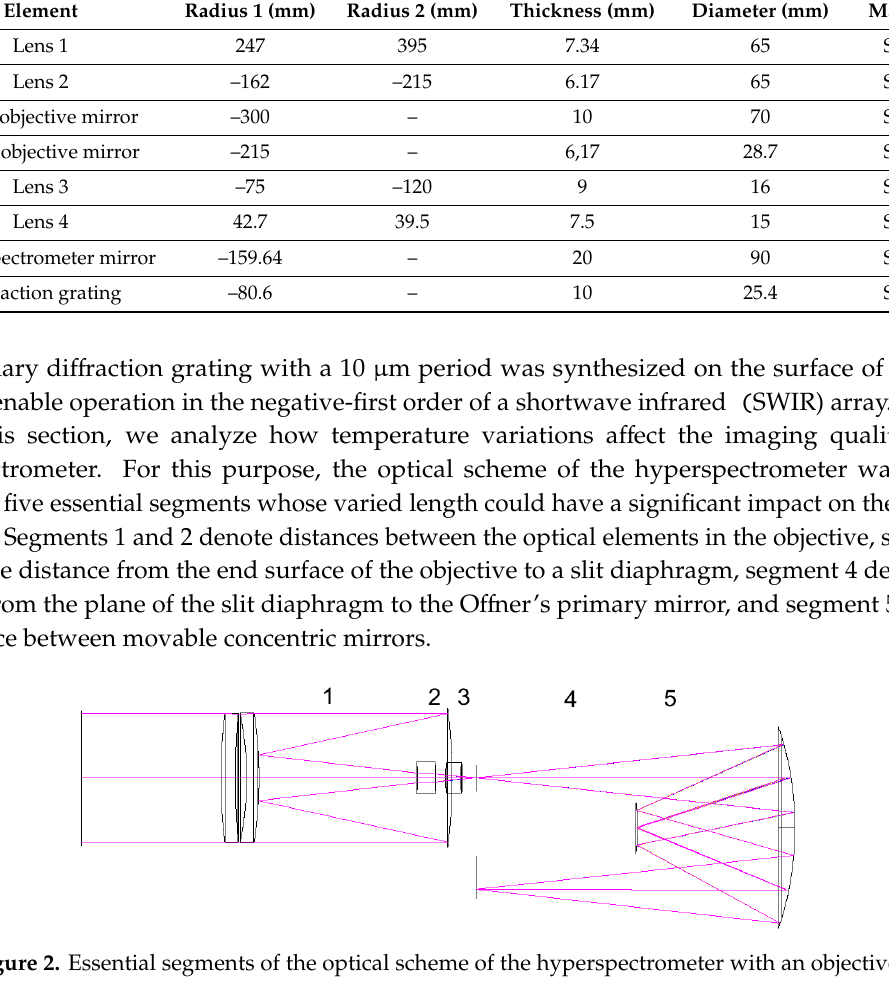
Table 1. Major parameters of Offner imaging hyperspectrometer.